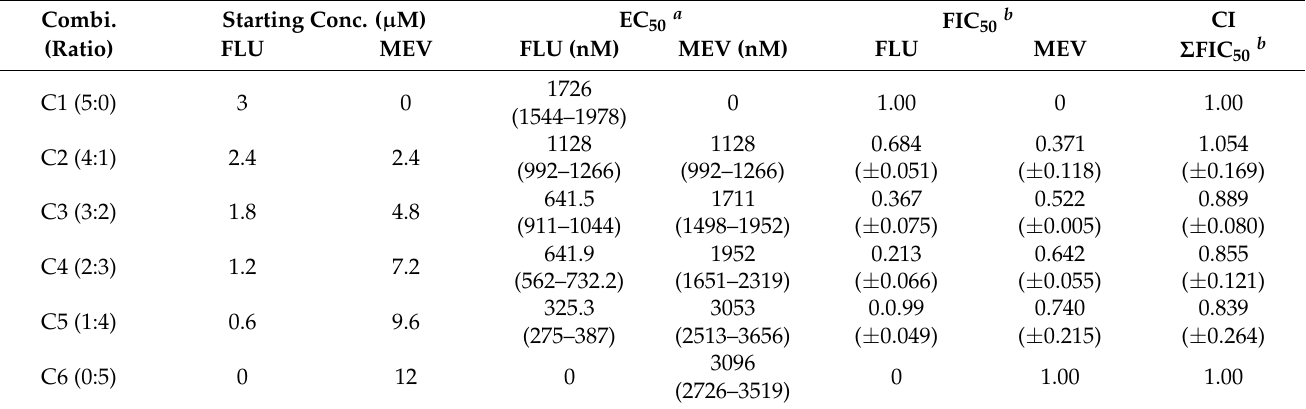
Table 3. Half-maximal inhibitory concentrations of the fluvastatin and mevastatin combinations. Combi.